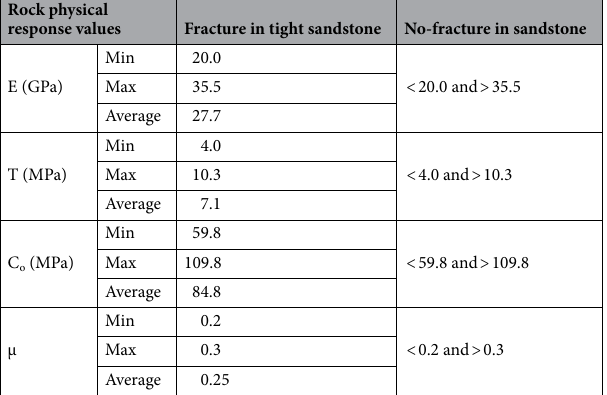
Table 2. Rock physical response values of fractured and nonfractured tight